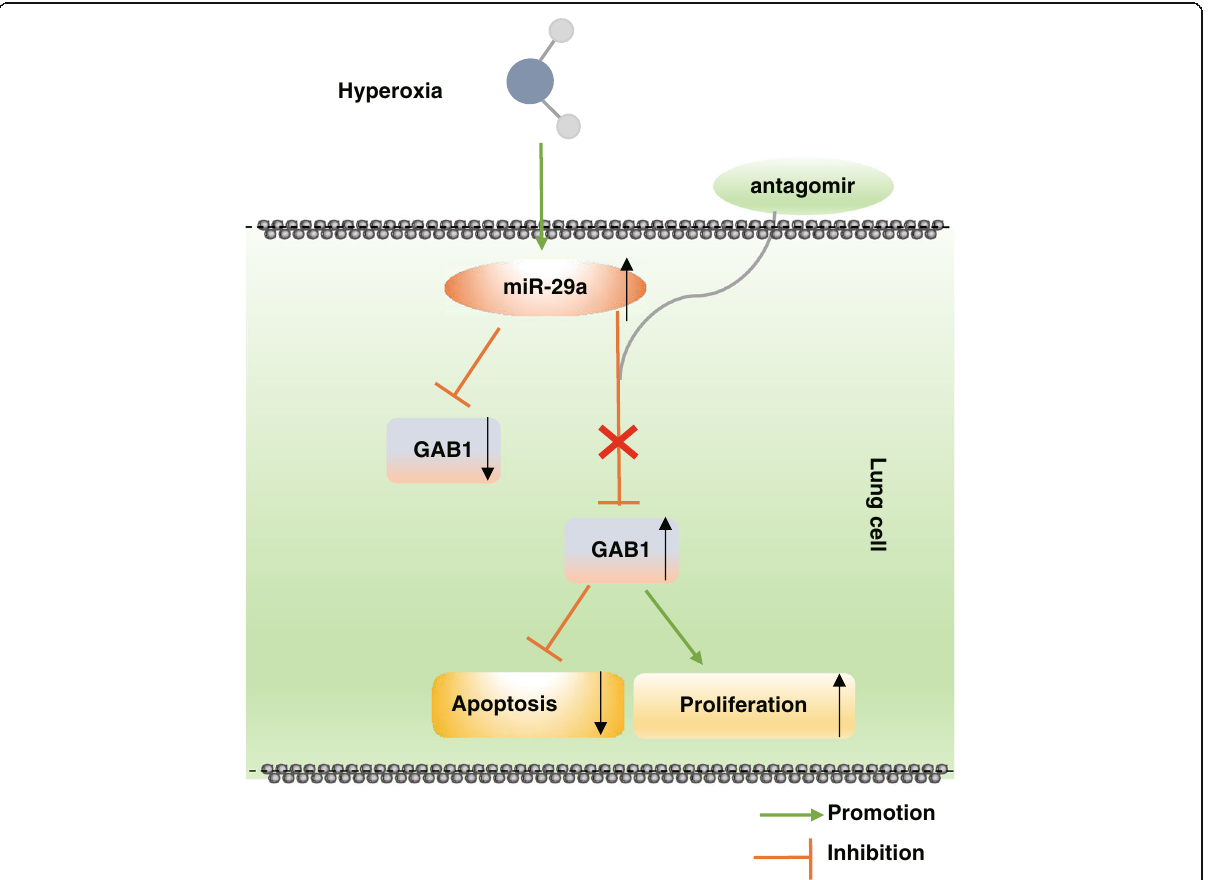
Fig. 5 Schematic representation of miR-29a in hyperoxia-induced BPD in neonatal mice. miR-29a is highly expressed and GAB1 is lowly expressed in hyperoxia-induced BPD in neonatal mice. Downregulation of miR-29a attenuates cell apoptosis and promotes cell proliferation in lung tissues by increasing GAB1 expression, ultimately retarding the development of BPD. miR-29a, microRNA-29a; GAB1, GRB2-associated-binding protein 1; BPD, bronchopulmonary